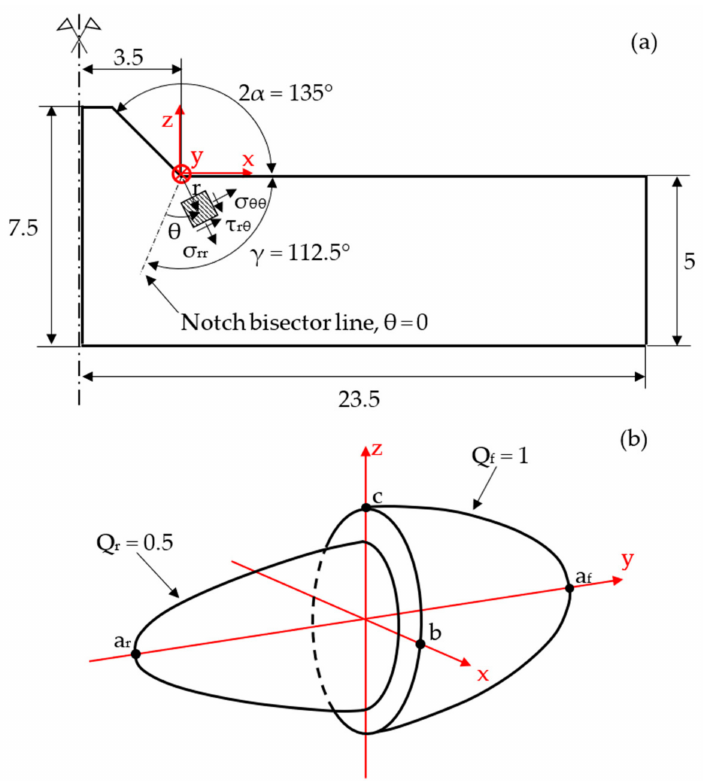
Figure 4. ( a ) Geometry of the analyzed butt-welded joint. ( b ) Double ellipsoid heat source. Repro- duced with permission from [42] (Copyright 2019